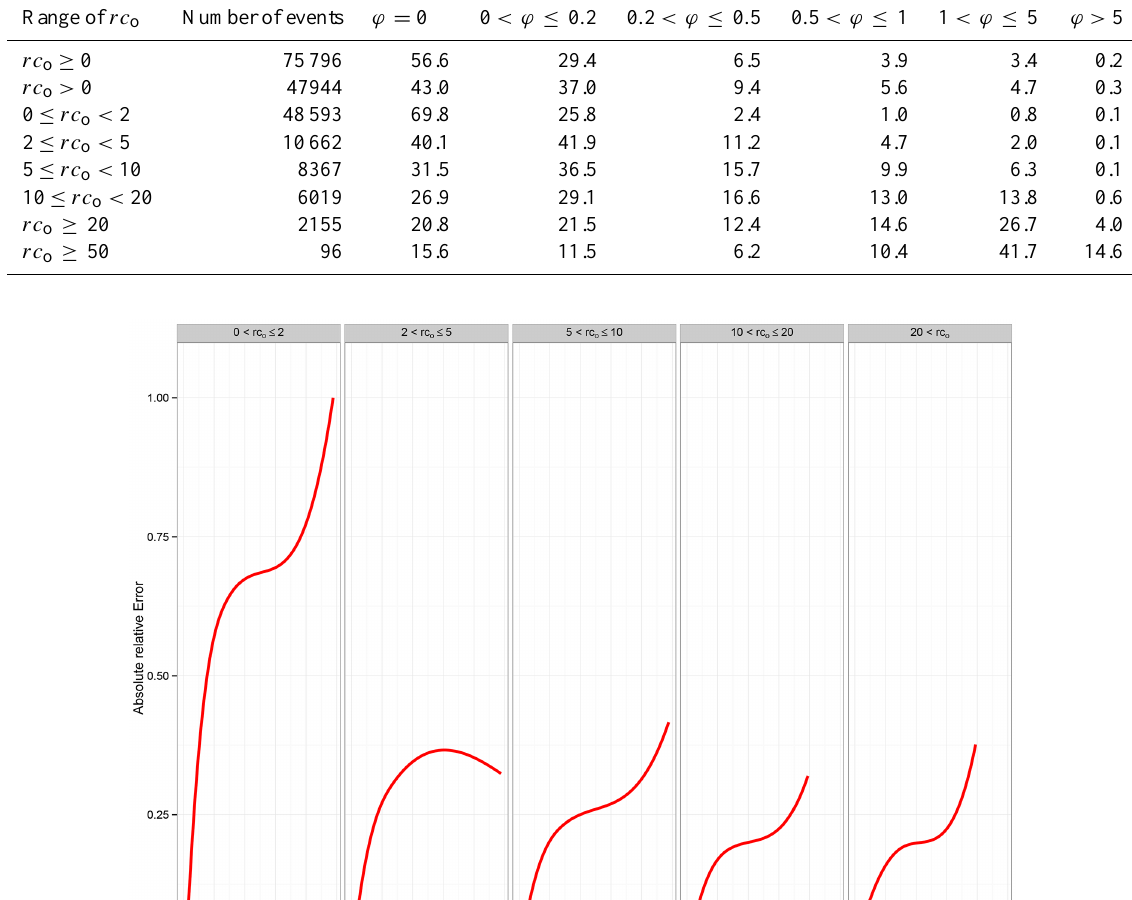
Table 3. Repartition (%) of the difference in absolute relative errors (Eq. 7) between the monthly corrected estimates and the standard estimates across different range of observed rainfall ( rc o ) events for the observed data of the Scottish validation data, in which days were only retained when the tipping bucket was at least 5km away from any of the daily gauges used to derive the rainfall grids.